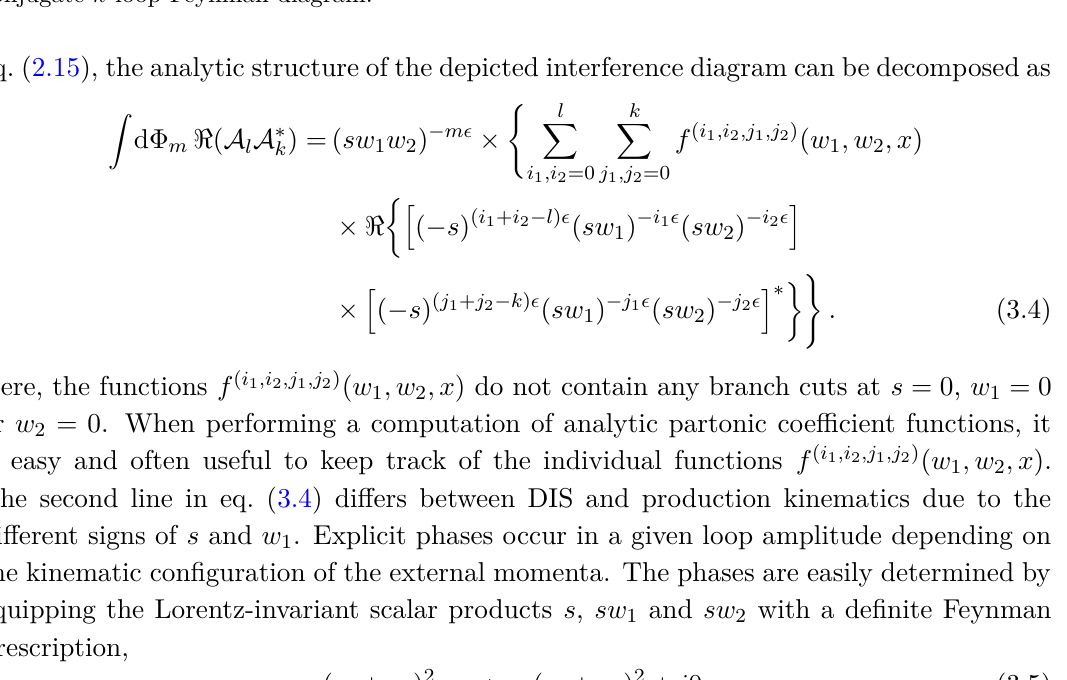
Figure 2 . Schematic picture of the interference of a l -loop Feynman diagram with a complex- conjugate k -loop Feynman